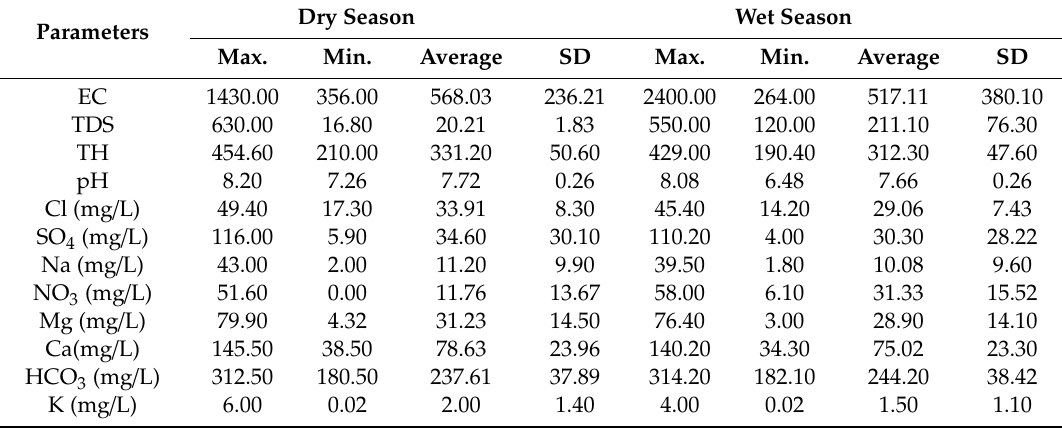
Table 5. Chemical investigation of groundwater of the HSB (both seasons). TH: total hardness.